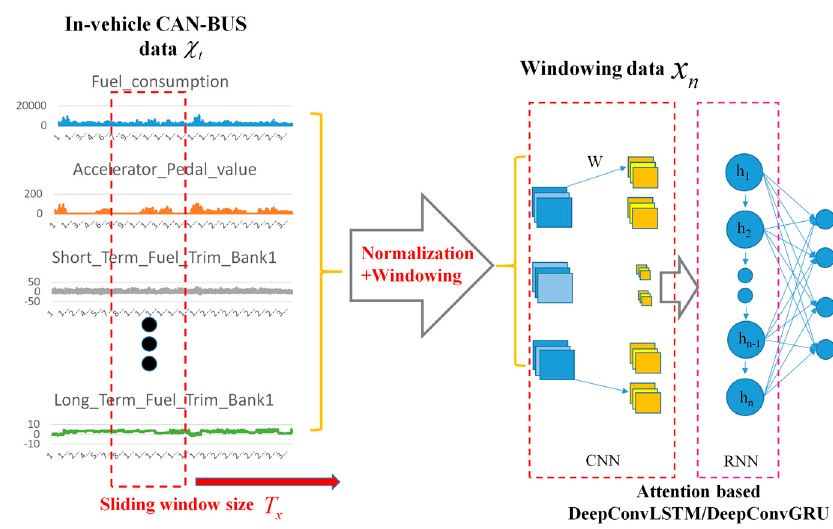
Figure 1. The outline of our approach.